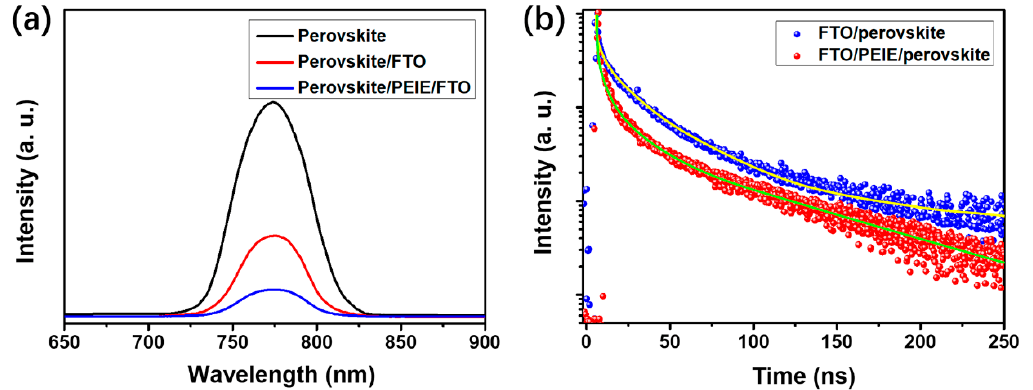
Figure 5. PL ( a ) spectra and time resolved-PL (TR-PL) ( b ) responses for devices of perovskite on glass, perovskite on pristine FTO and perovskite on FTO/PEIE substrates.